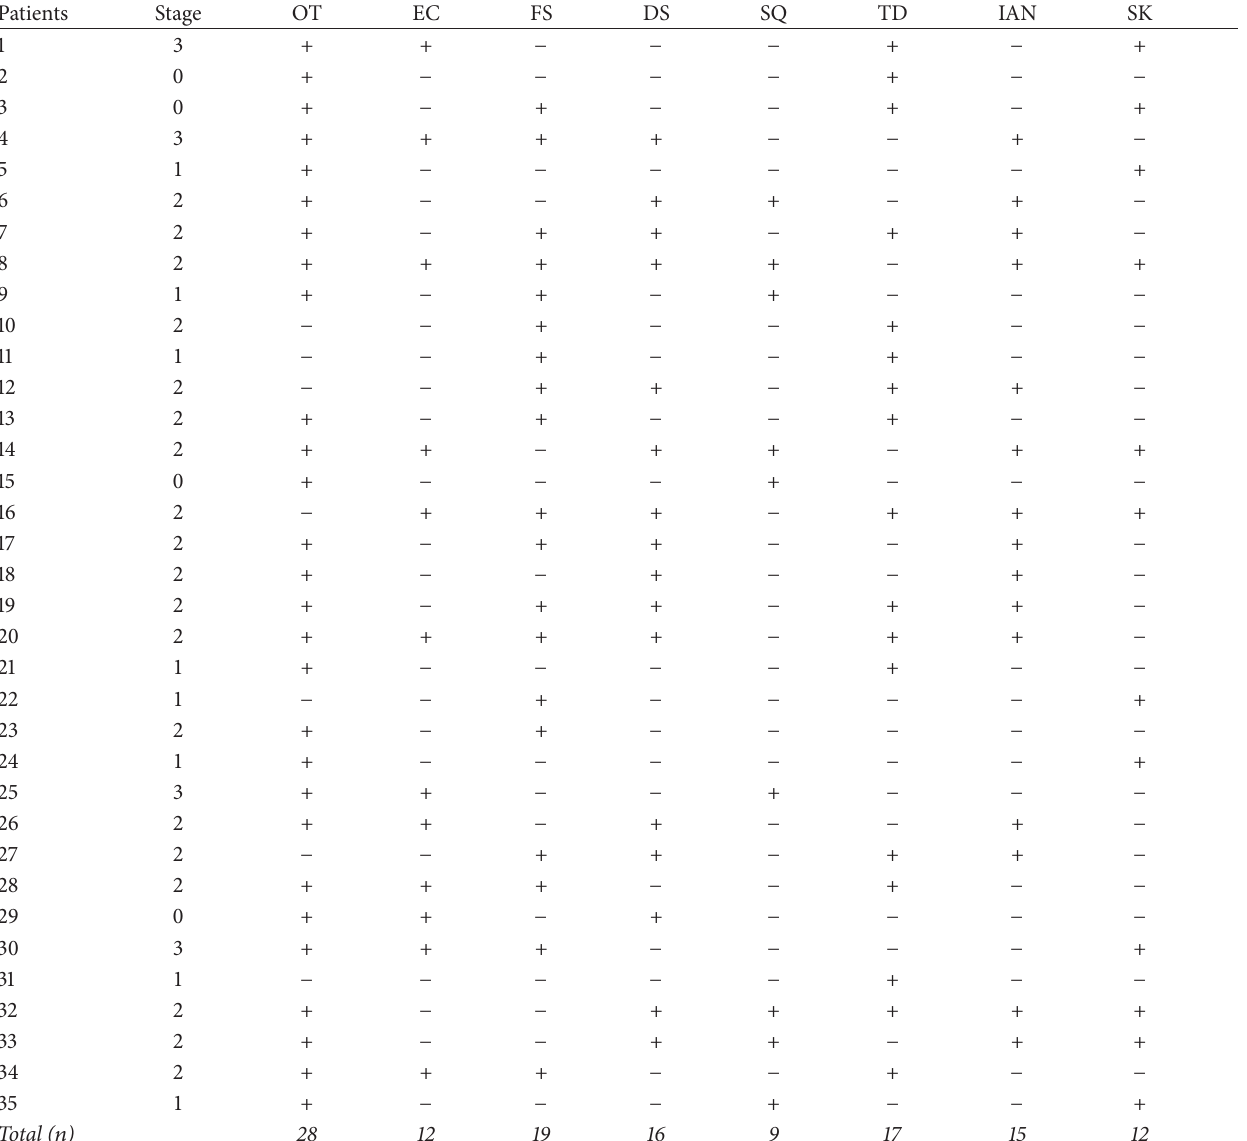
Table 2: Radiographic findings of 35 patients with MRONJ. Osteolysis (OT), erosion of cortical bone (EC), bone sclerosis focal (FS) and diffuse sclerosis (DS), bone sequestration (BS), thickening in the lamina dura (TD), prominence of the inferior alveolar nerve canal (IAN), persisting alveolar sockets (SK), and presence of pathological fracture (PF).